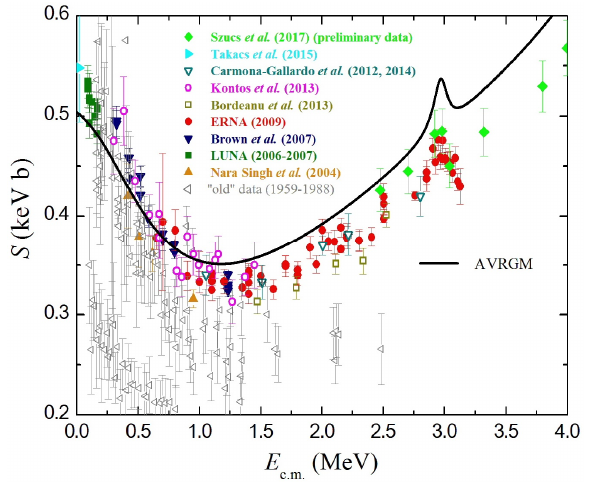
Fig. 1. Energy dependence of the 3 He( α , γ ) 7 Be total astrophysical S factor